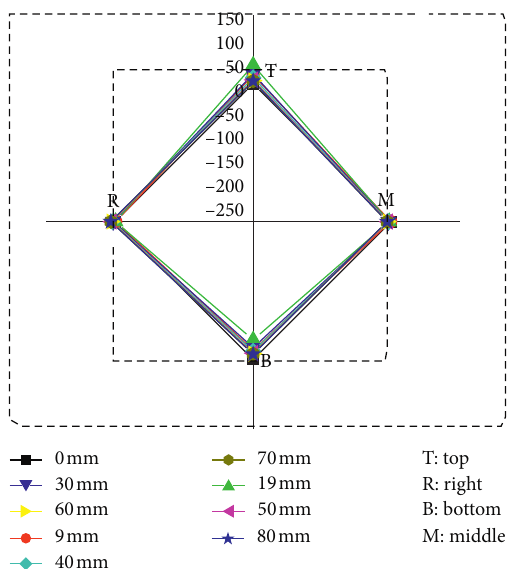
Figure 20: Intersection position of structure and ground fissure cabin 1 displacement.